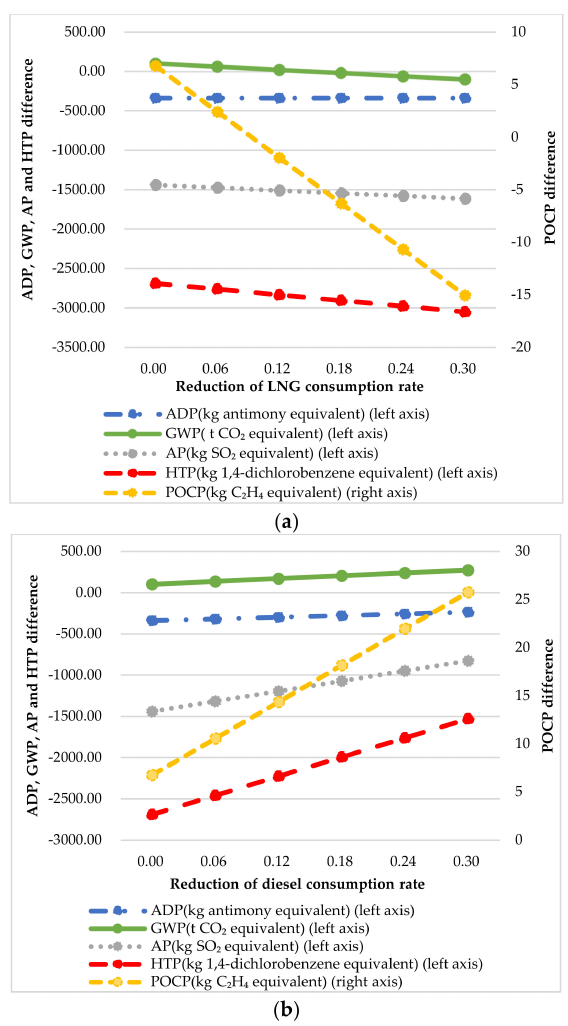
Figure 6. The impact of the fuel consumption rate on the differences in five categories of environmen- tal impacts: ( a ) reduction of LNG consumption rate; ( b ) reduction of diesel consumption